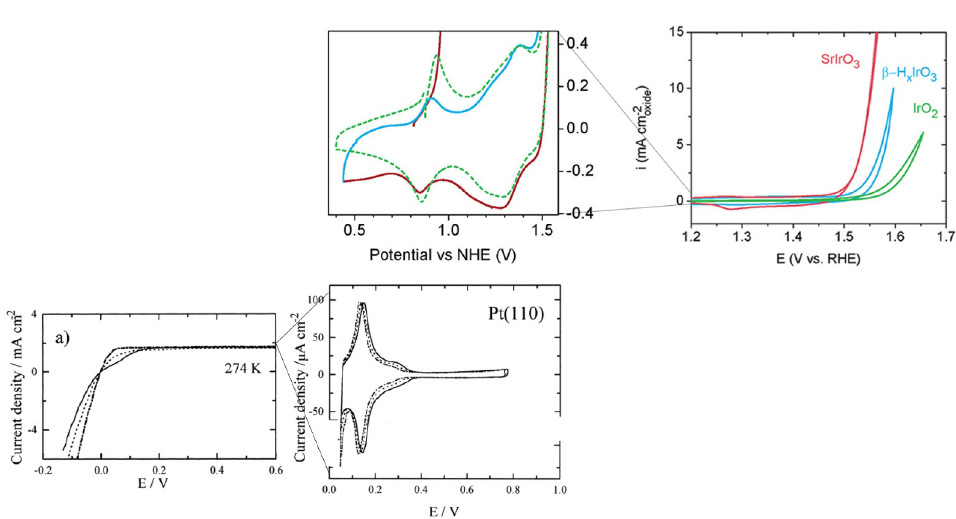
Fig. 9. – Top: CV and potential curve for OER on three different iridium-based catalysts. In the center, the corresponding CV is shown, on the right side the polarisation curve for OER is plotted. Figure adapted with permission from [43]. Bottom: Analogous CV (center) and potential curve for HER (left) on platinum. Figure adapted with permission from